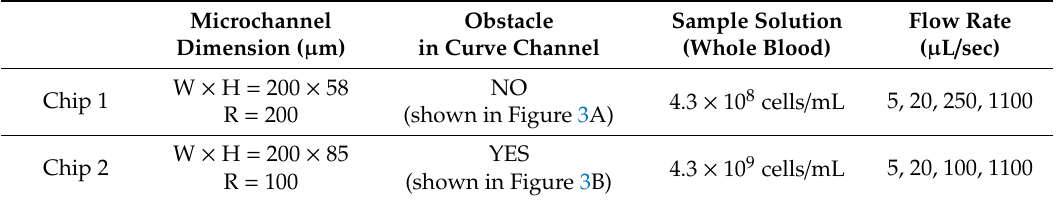
Table 1. Parameters used for blood cell separation using Chip 1 and Chip 2.